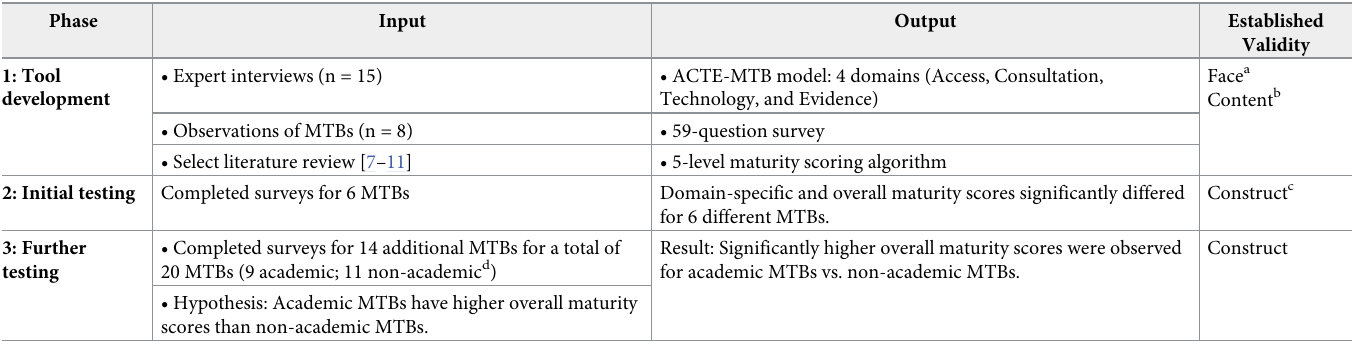
Table 1. A 3-phased strategy for development and validity testing of the ACTE-MTB maturity